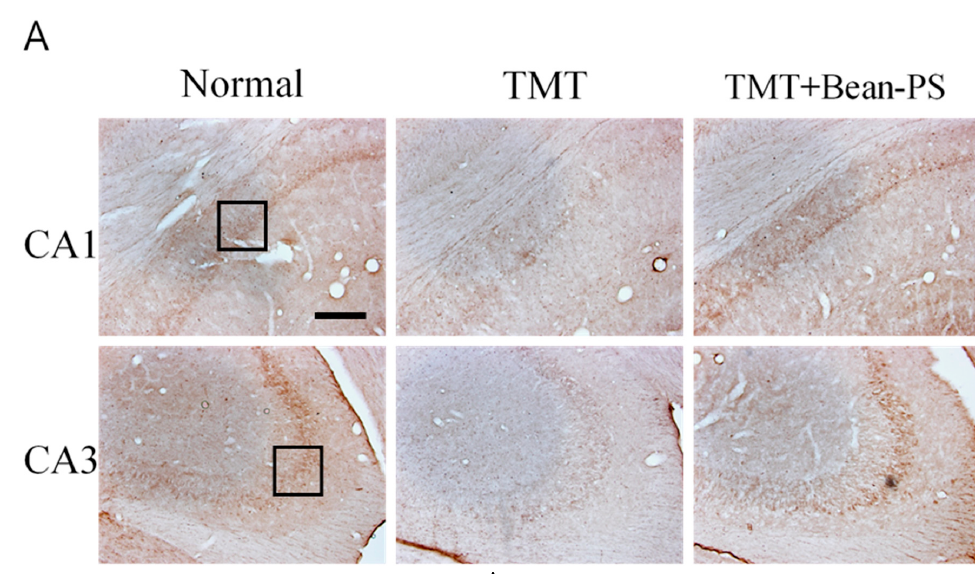
Figure 3. Effect of Bean-PS on the number of choline acetyltransferase (ChAT)-positive neurons in the hippocampus. Representative photographs and the number of positive neurons are indicated in ( A ) and ( B ). Black square represents region of CA1 and CA3 in the hippocampus and the scale bar represents 200 μ m. Results are expressed as means ± S.E.M. *** p < 0.001, ** p < 0.01 vs. normal group, # p < 0.05 vs. TMT group. Normal group ( N = 9); TMT group ( N = 5); TMT-Bean-PS ( N = 5).